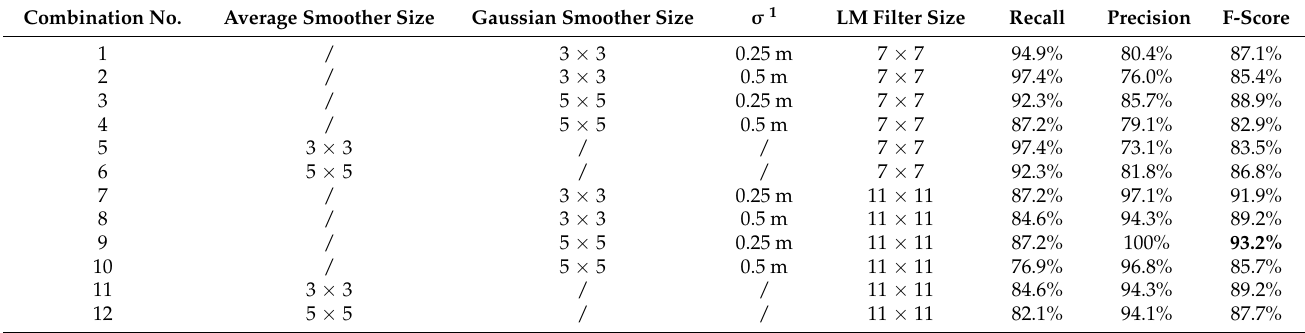
Table 3. List of LM extraction-related parameter values and corresponding tree detection results for comparison on test site 2. The values of the parameters related to filtering of initially extracted LMs were fixed. MaxD = 1.5 m, significance level = 0.10, and score threshold = 9. Combination